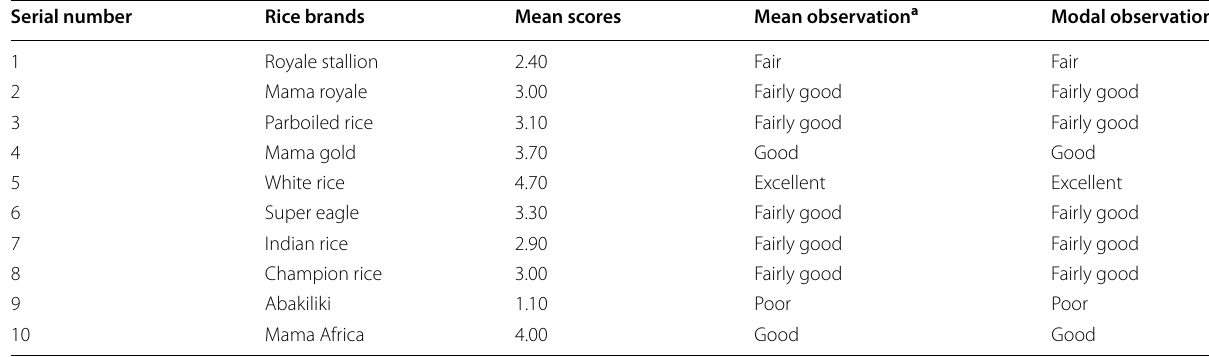
Table 2 Appearance of ten rice brands ascertained by panelist of rice consumers